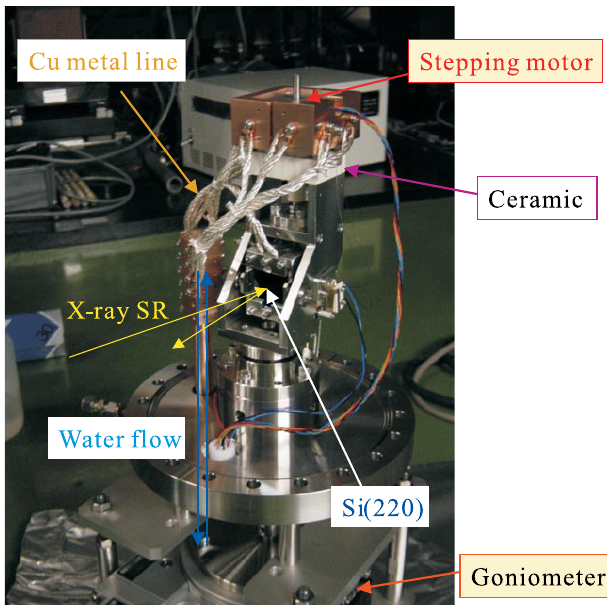
FIG. 3. (Color) Picture of the new Si